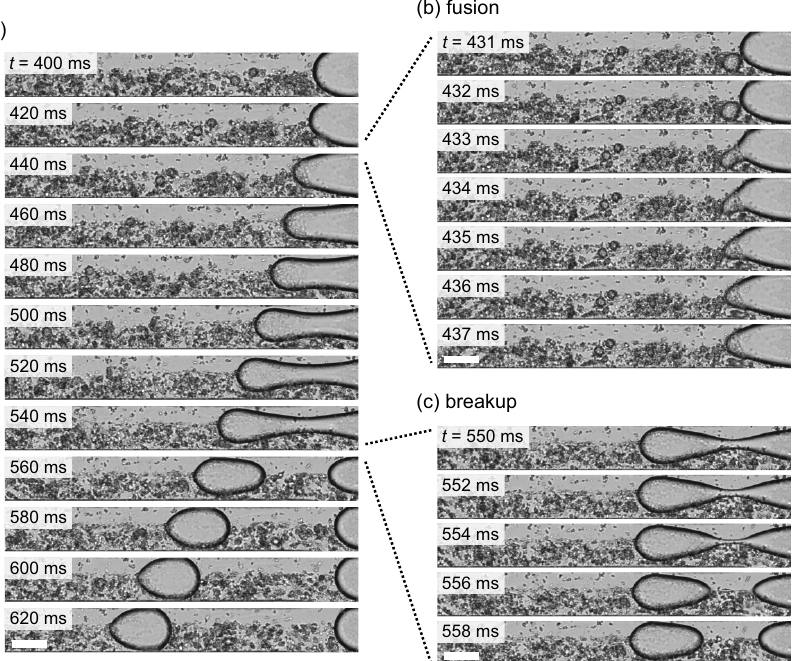
Figure 4. ( a ) Snapshots of the generation of a droplet with an asymmetric shape. t = 0ms was set at the timing when the NaAlg aqueous phase retreated the most during periodic dripping. ( b ) Detailed view of the fusion with a small CaCl 2 emulsion. ( c ) Detailed view of the split of the droplet from the NaAlg aqueous phase. All scale bars, 50 µ m. The video is available in Supplementary materials (Video S2).